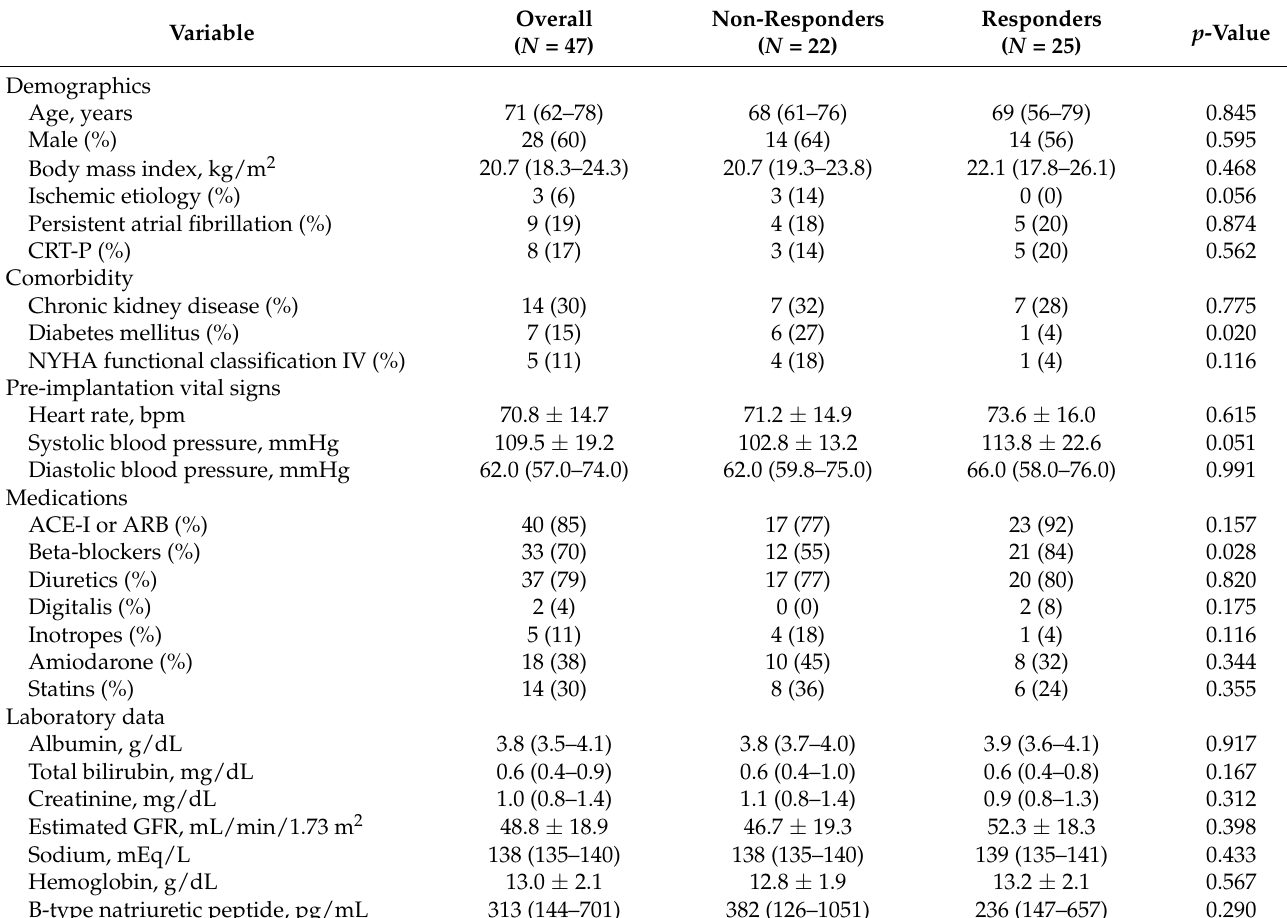
Table 1. Comparison of clinical characteristics between responder and